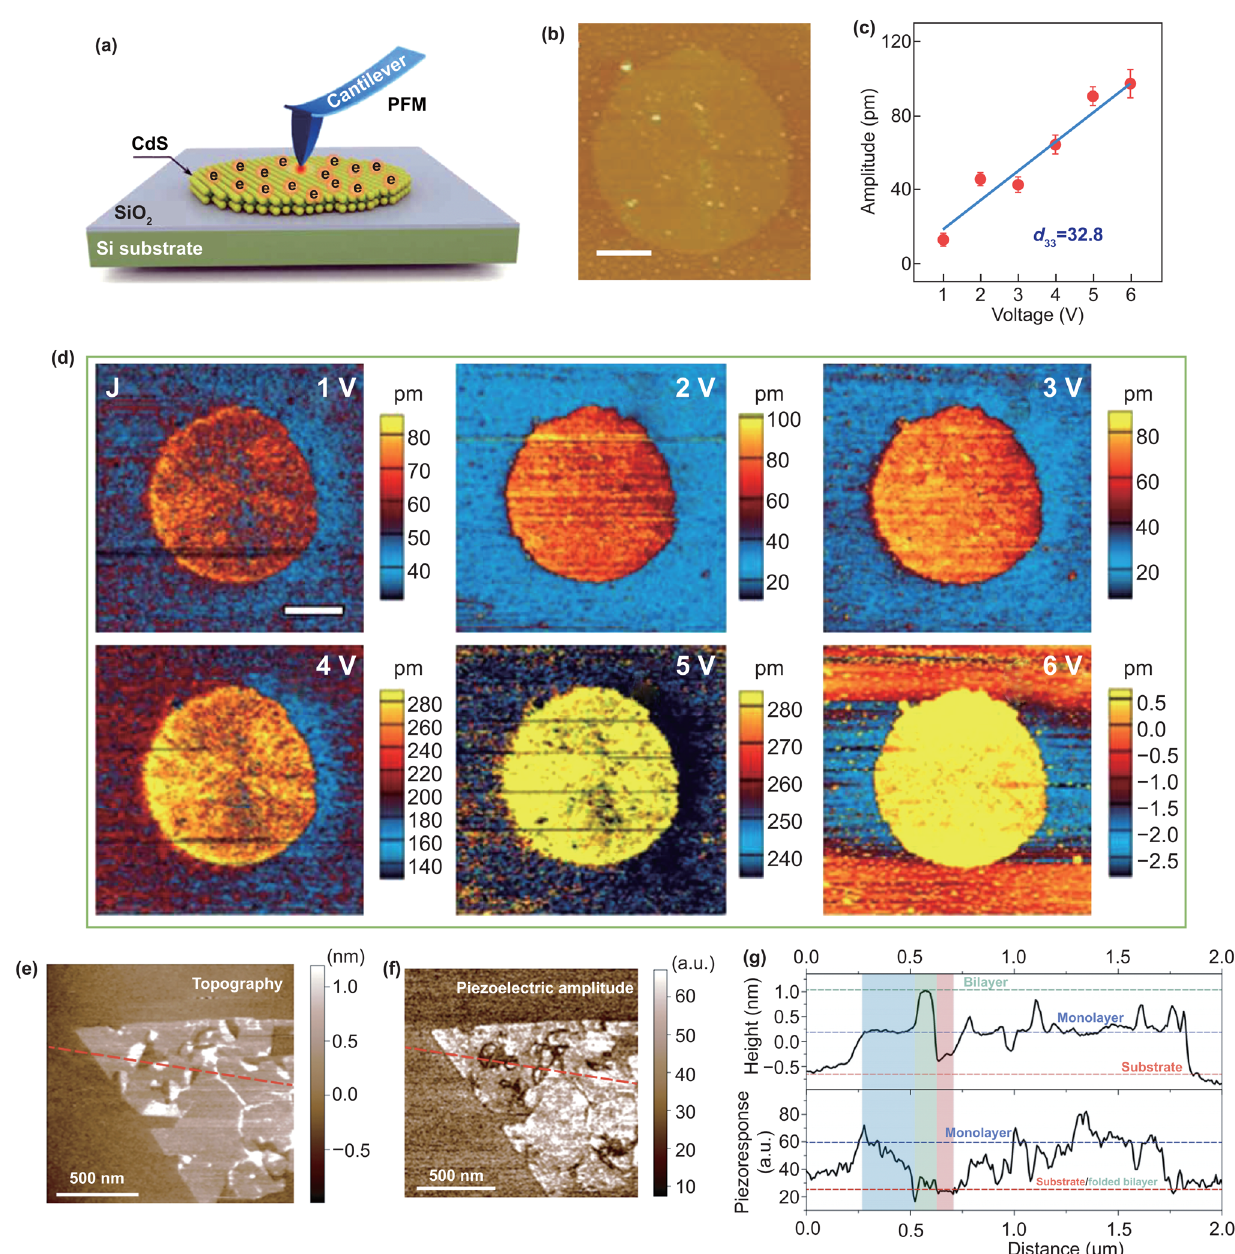
Fig. 12 Observing out-of-plane piezoelectric effect by PFM mode. a Schematic illustration of PFM measurement. b AFM topography images of the 2D CdS. c Average amplitude variations versus applied voltages. d Piezoelectric amplitude images observed by PFM technology with tip voltages from 1 to 6 V. Reproduced with permission [173]. Copyright 2018, AAAS. e Topography and f piezoelectric amplitude image a monolayer Janus MoSSe. g The step height and piezoelectric amplitude profile along the dashed lines in e, f . Reproduced with permission